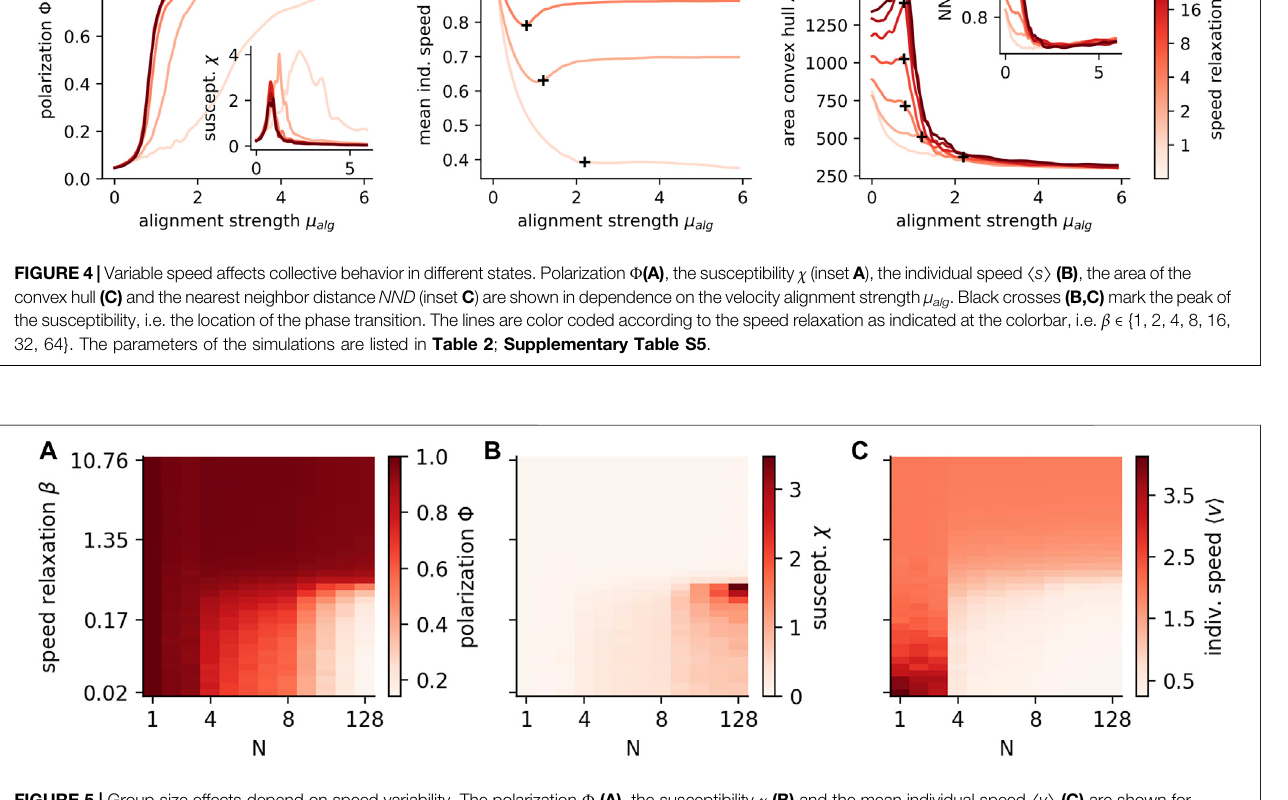
FIGURE 5 | Group size effects depend on speed variability. The polarization Φ (A) , the susceptibility χ (B) and the mean individual speed 〈 v 〉 (C) are shown for different speed relaxation β and group sizes N . The parameters of the simulations are listed in Table 2 ; Supplementary Table S5 with the difference of a preferred speed of v 0 (cid:1) 2.